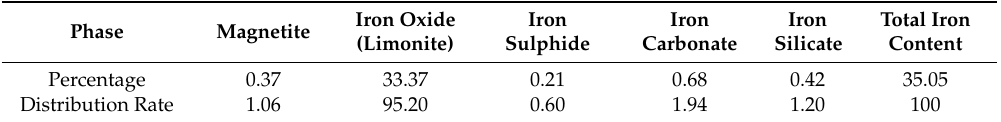
Table 1. Phase analysis results of